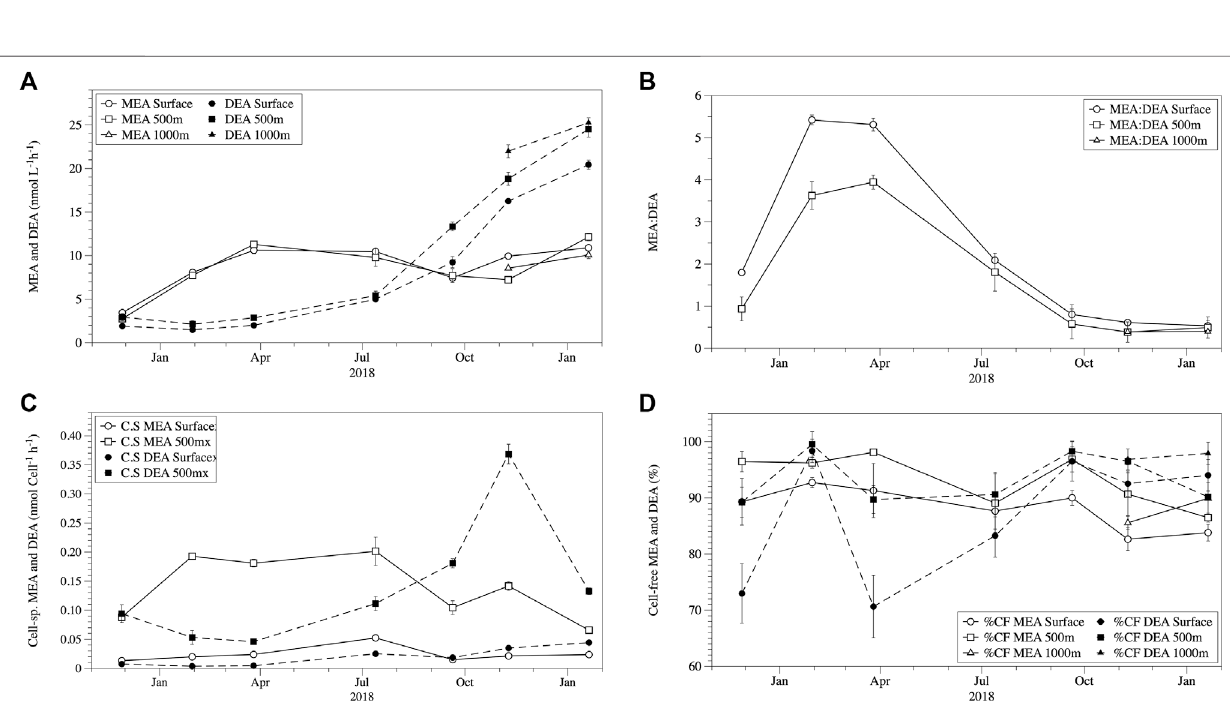
FIGURE 2 | Seasonal variation in mean ( ± SE) total phosphomonoesterase activity (MEA) and phosphodiesterase activity (DEA) (A) , the ratio of MEA to DEA ( ± SE) (B) , themean ( ± SE) cell-speci fi cMEAand DEAgiven innmol/cell − 1 /h − 1 (C) ,and themean ( ± SE) cell-free (CF) fractions for MEAand DEA (D) inthe epi-and mesopelagic layer at the study